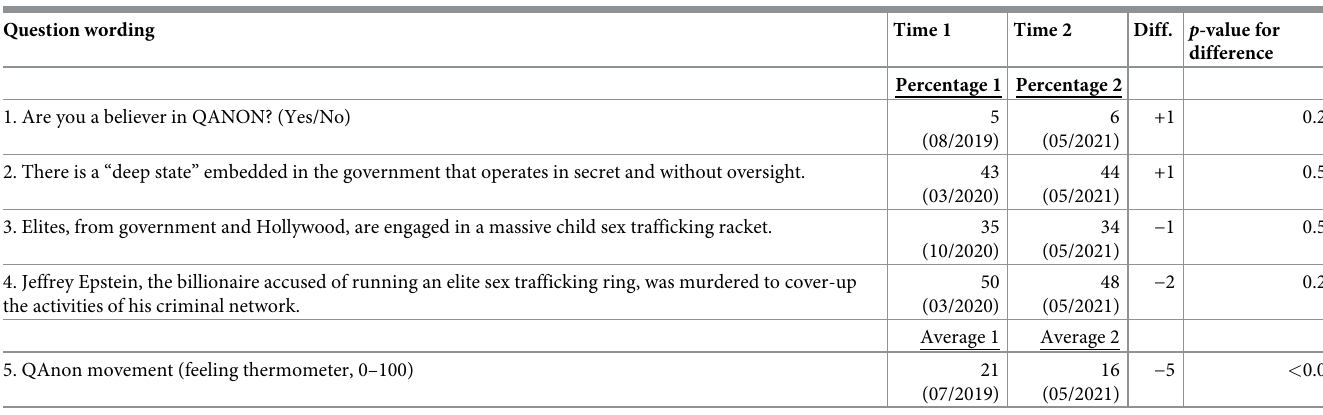
Table 2. Change in QAnon and QAnon-related beliefs over time. Question